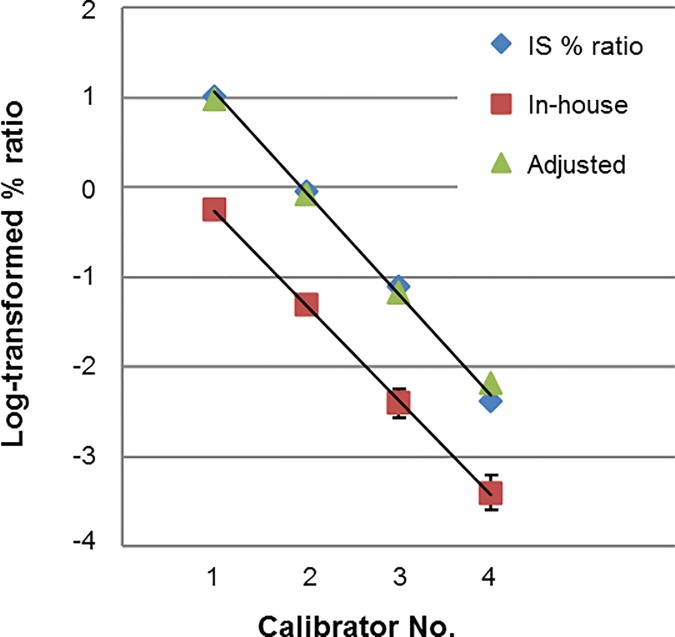
Evaluation of the accuracy of the in-house method in comparison to WHO reference panel IS, International scale.